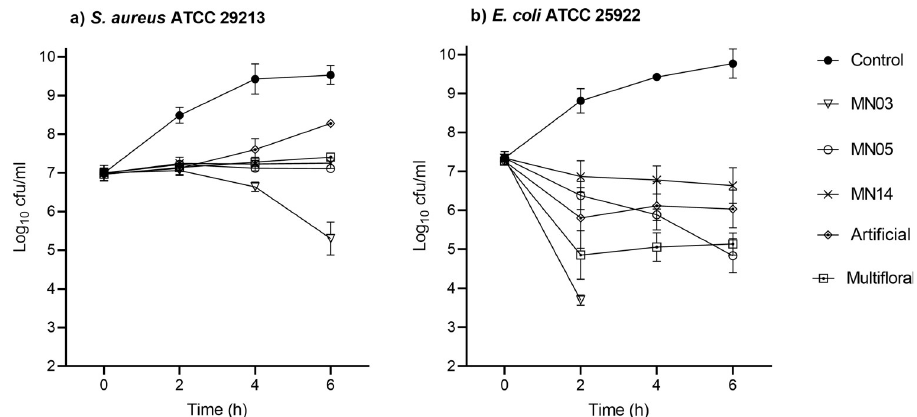
Fig 3. Time kill curves of thee manuka honeys with varying MGO content, a multifloral honey and artificial honey against S . aureus ATCC 29213 and E . coli ATCC 25922. MGO content was 1022, 326 and 75 mg/kg for honeys MN03, MN05 and MN14, respectively. For both organisms, viable counts for all honey treatments differed significantly from the untreated controls at each time point.